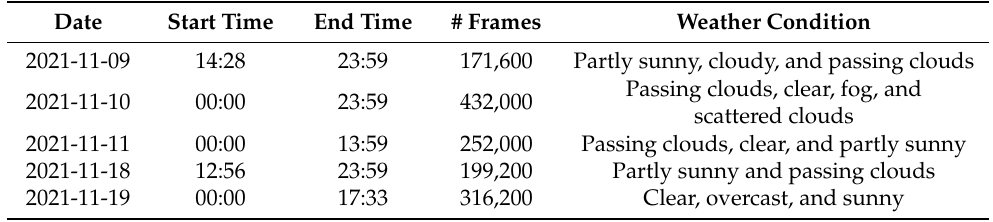
Table 2. Log of experimental trials conducted with the TurbNet-LED